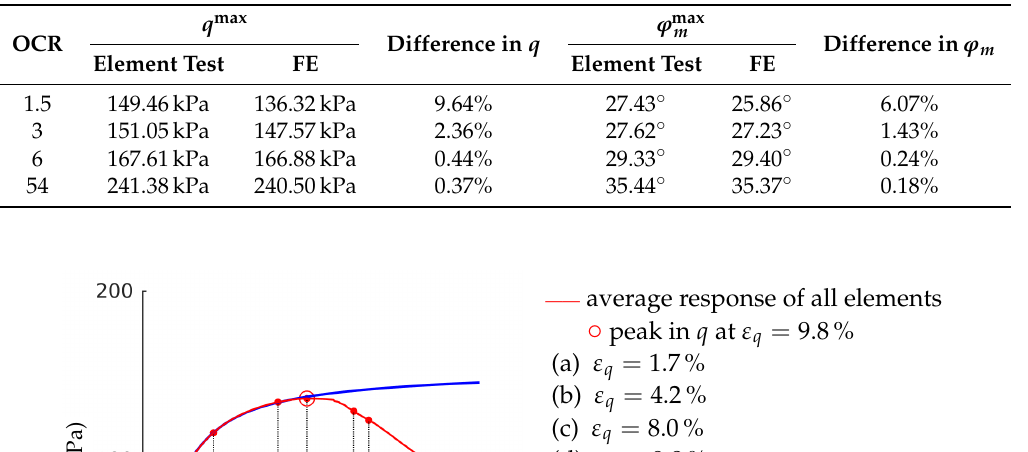
Table 3. Maximum deviatoric stress q max in the element test and in the average response of all elements and maximum mobilized friction angles ϕ max m in the element test and in the average response of all elements.